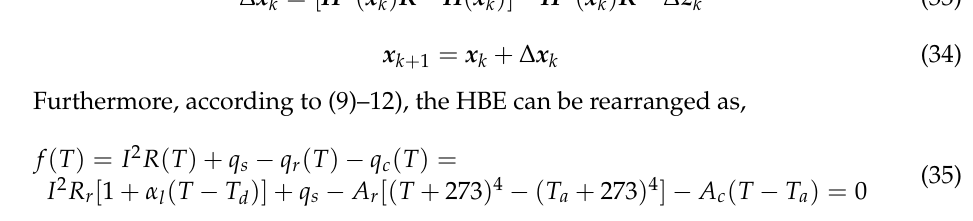
Figure 3. Framework of the proposed ITS-ETC-ES approach.